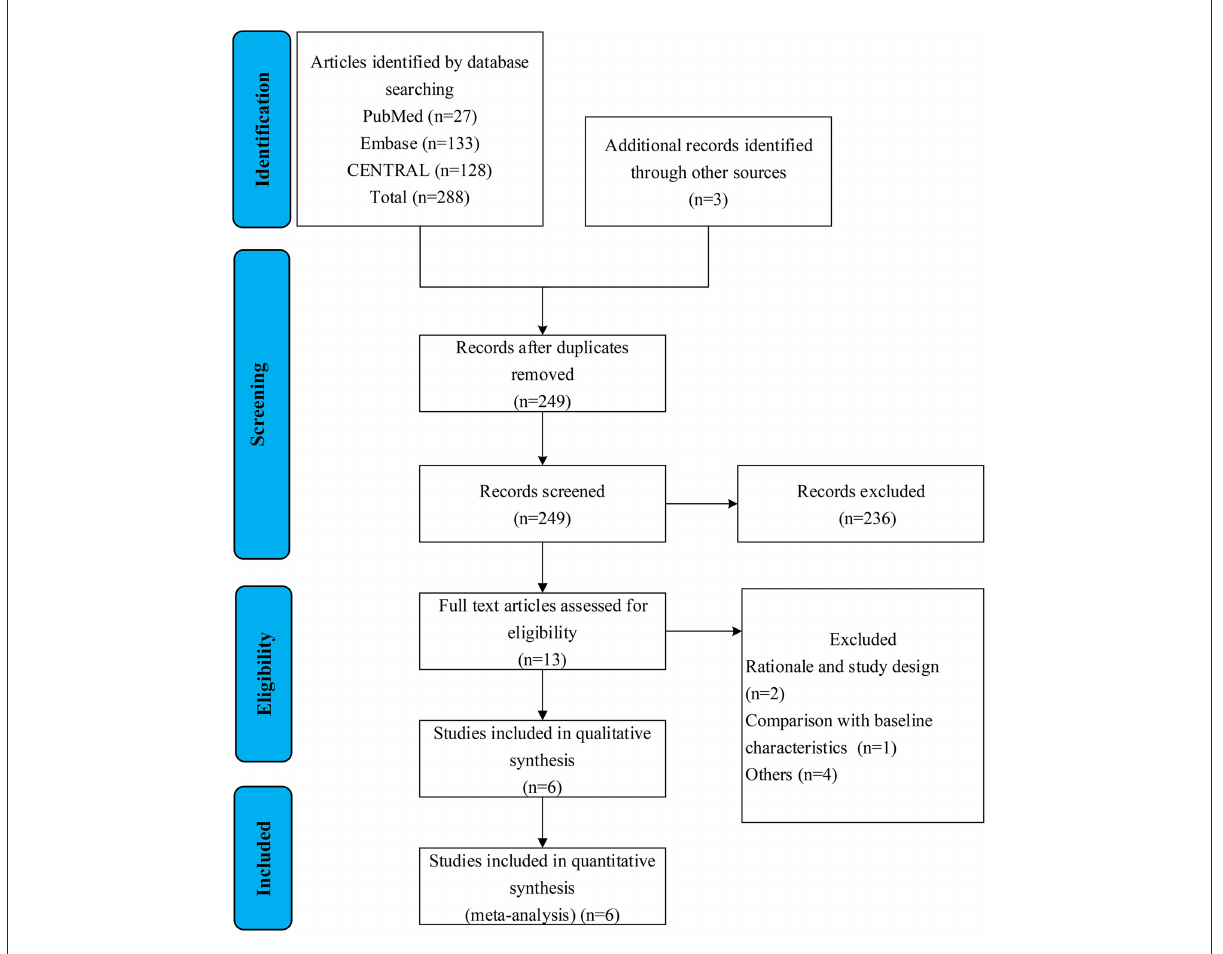
FIGURE1 Selection flow chart of literature